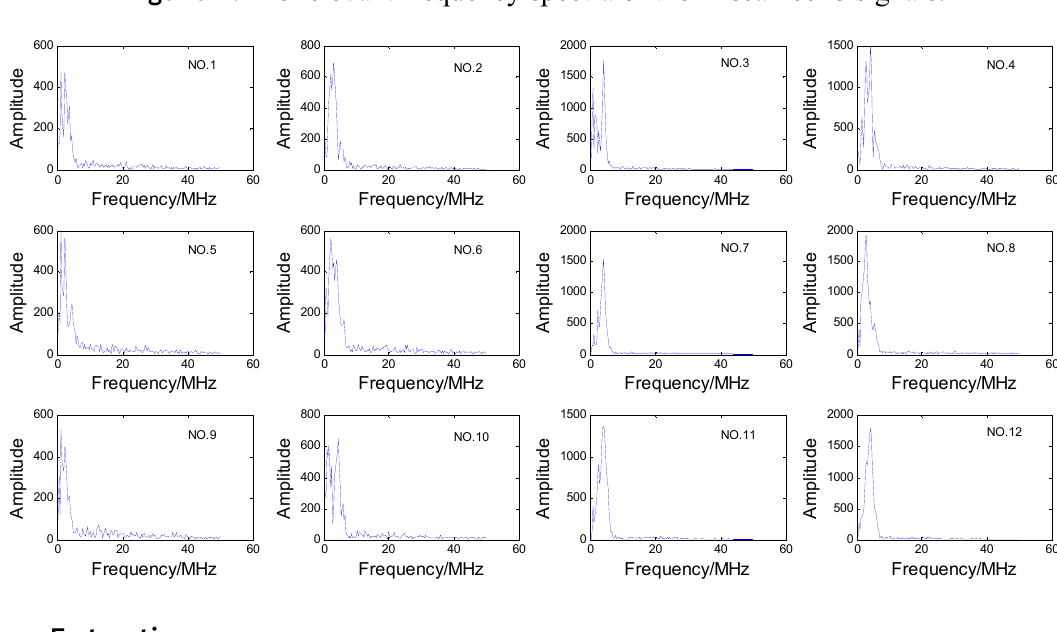
Figure 4. The relevant frequency spectra of the A-scan echo